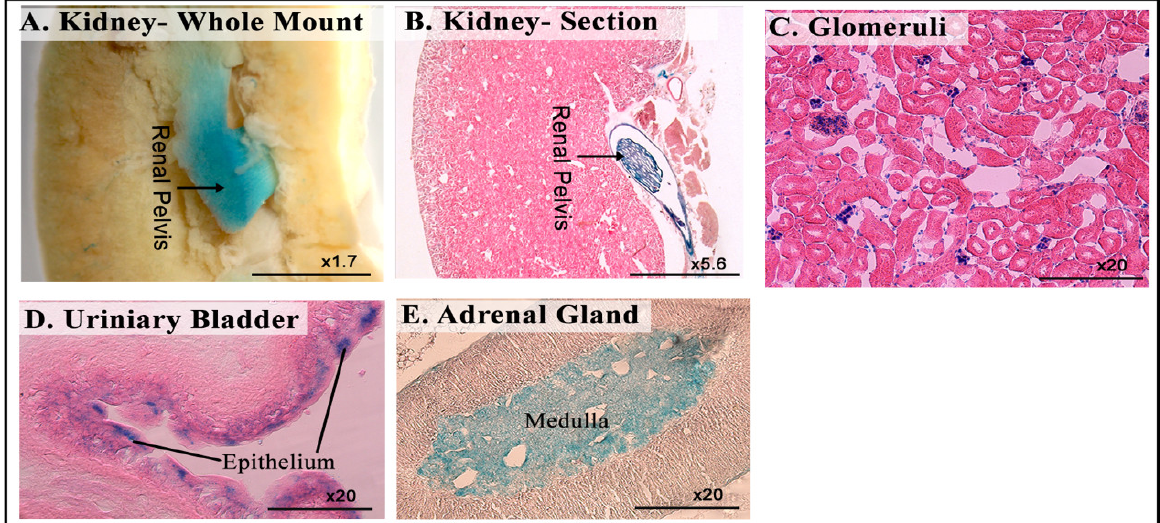
Figure 7. LacZ expression in the genitourinary system. ( A – C ) Whole-mount and frozen section LacZ staining of a kidney, showing X-gal signal at the renal pelvis and glomeruli. ( D ) Frozen section of a urinary bladder, showing LacZ signals in the epithelium. ( E ) Frozen section of an adrenal gland, showing LacZ staining in the medulla.